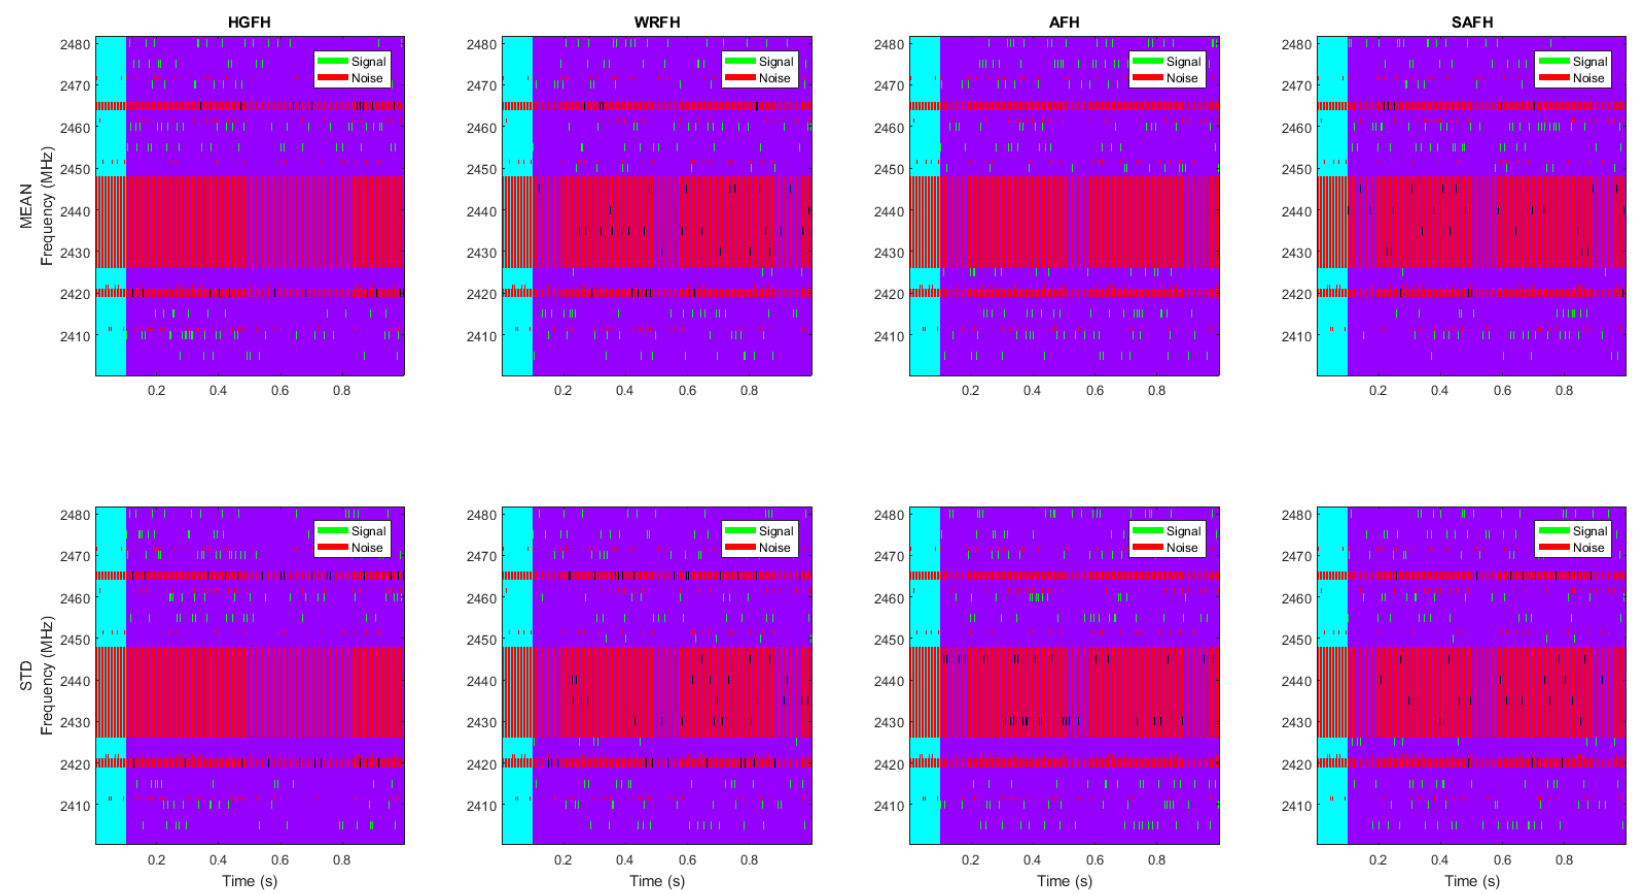
Figure 20. Frequency pattern of signal and noise for different hopping techniques and quality metrics. The interfering noise is represented in red and the signal of interest in green. The same noise pattern is considered for all the hopping techniques and all the quality metrics. Different hopping techniques and different quality metrics result in different frequency patterns for the signal of interest. The overlapping of the noise and signal of interest is represented in black.